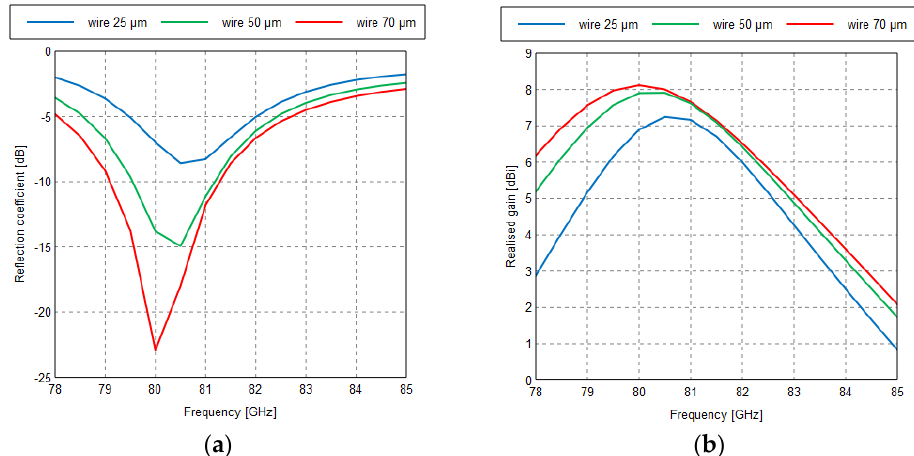
Figure 7. Simulations of the experimental design for different wire bond diameters: ( a ) reflection coefficient; ( b ) realized gain (reflection loss included), broadside direction.